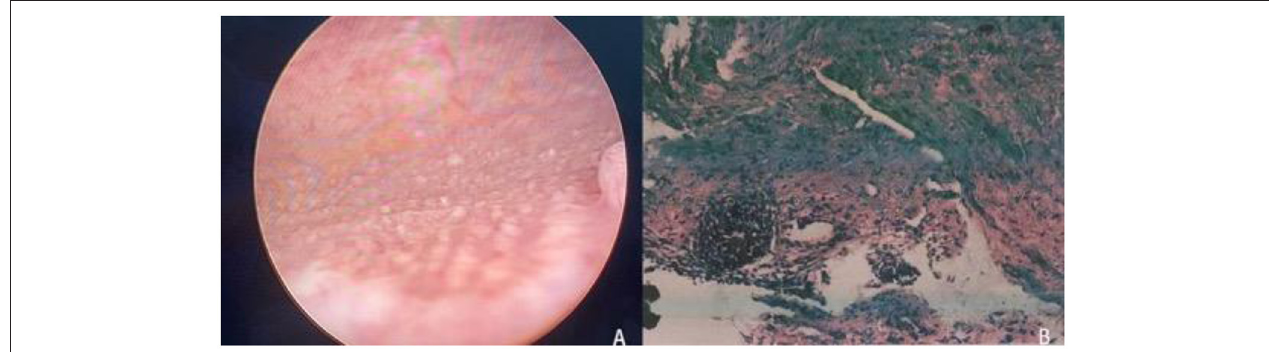
FIGURE 1 | (A) Cystoscopy revealed multiple follicular masses in the trigone of the bladder. (B) Pathological examination: the submucosa can be seen with adenoid-shaped cell clusters, and the surface of the glandular lumen is covered with normal urothelial cells (H.E ×